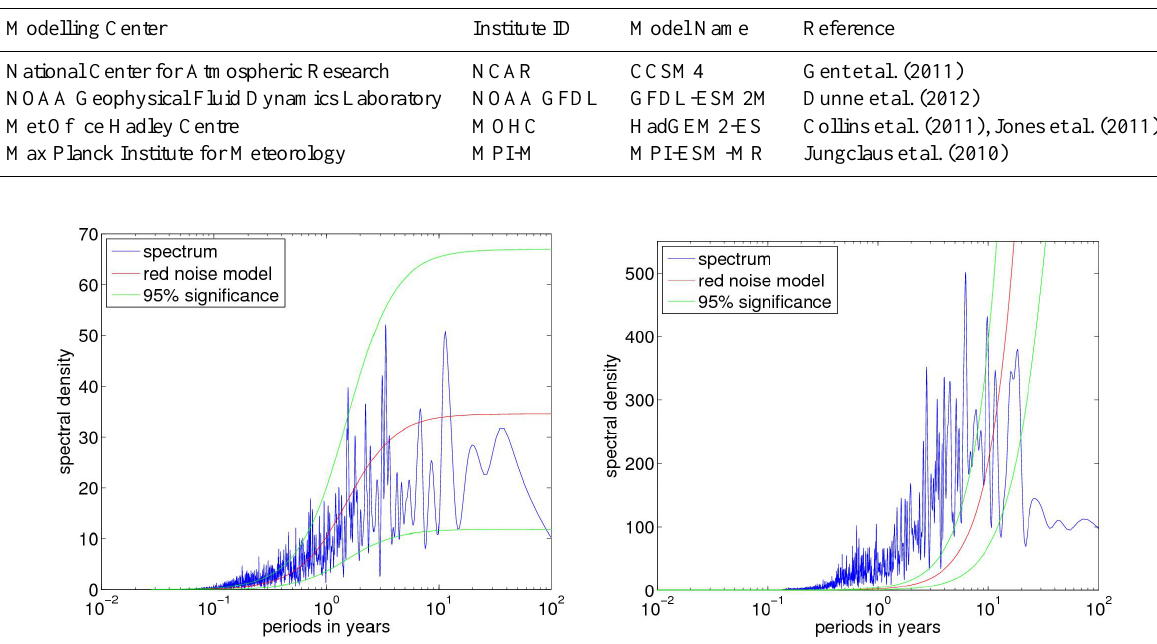
Fig. 7. (a) Power spectrum of PC 1 at 833hPa geopotential height for the atmosphere-only model. The last 800yr of a 1000yr run. (b) The same as in (a) , but for the coupled